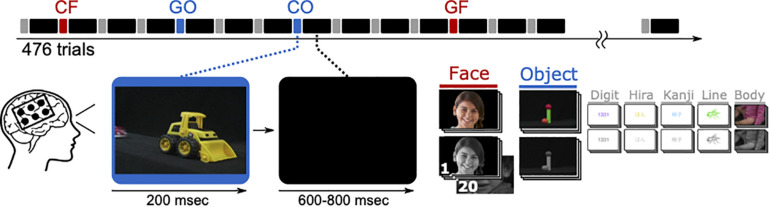
One ECoG paradigm lasts 476 trials, each with 200 ms presentation time and 600–800 ms inter-stimulus-interval, resulting in 333 s on average. Trials showing faces (CF and GF) or objects (CO and GO) were considered in the analysis. The visible face is representative for the original stimuli and used from a public database (copyright shutterstock).